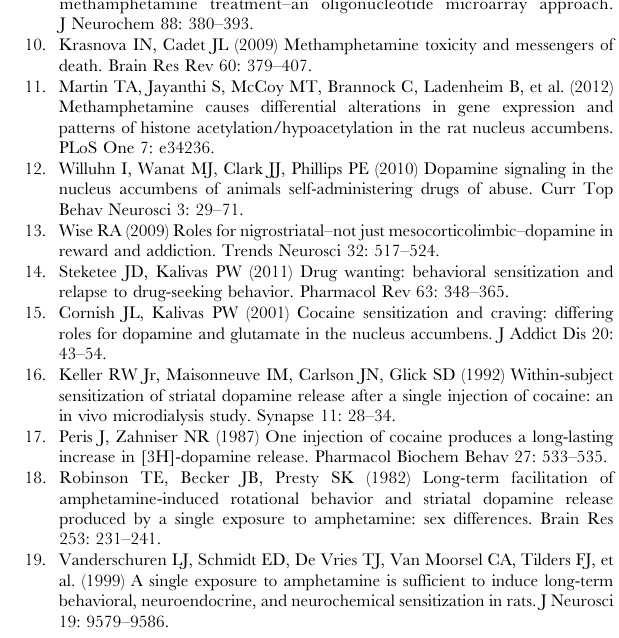
ment schedule.Table S1, RNA Integrity Number (RIN) of Samples. Table S2, List of RT-PCR primers.